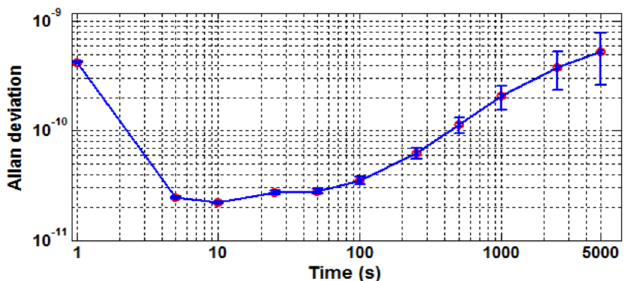
Fig. 7. Allan deviation of f beat between Tesa RSD/SR and femtosecond comb. Error bars corresponding to the standard uncertainty are shown for longer averaging times, where the error is large enough to be signi fi cant.